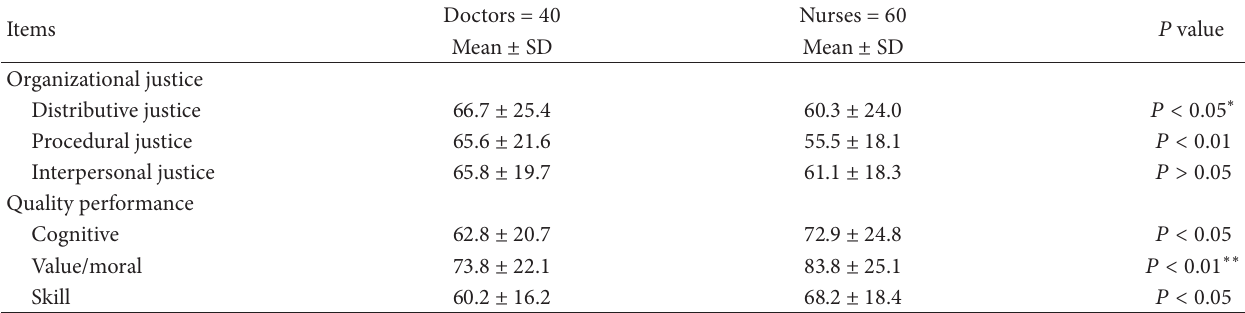
Table 2: The mean and SD of the study sample’s perception of organizational justices and quality performance among healthcare workers ( 𝑛 = 100 ).